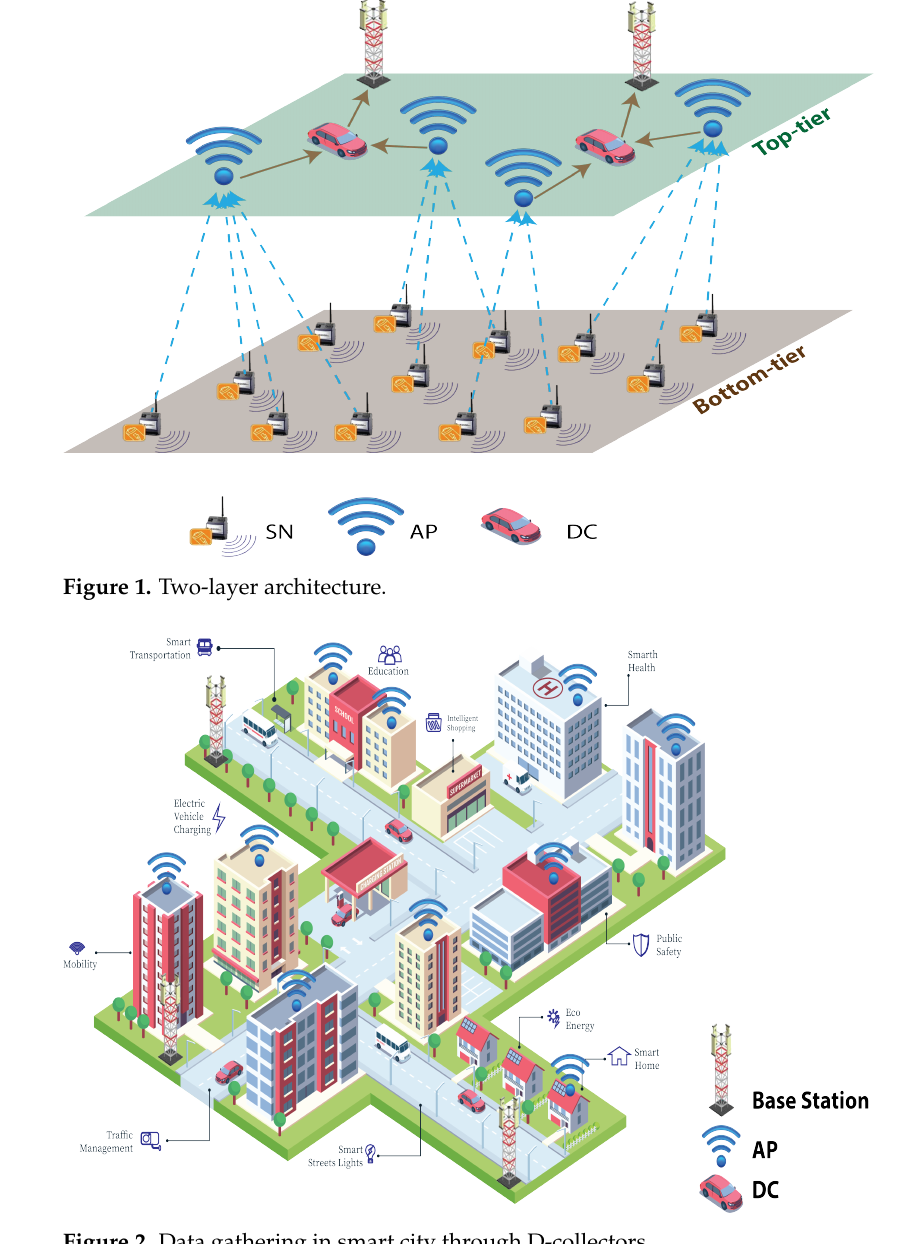
Figure 2. Data gathering in smart city through